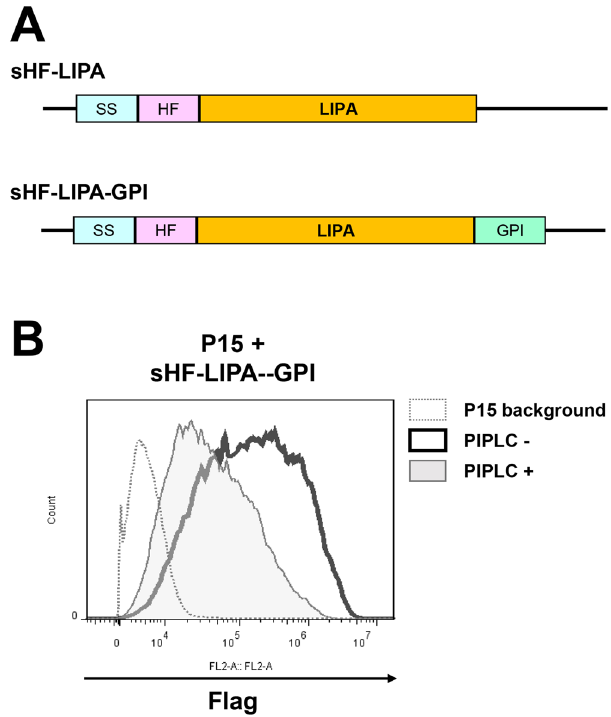
sequence (SS) and GPI attachment signal of human CD59 were used. ( B ) Flow cytometric analysis of sHF-LIPA- GPI on the cell surface of P15 cells. The cells were stained with an anti-Flag antibody and a PE-conjugated goat anti-mouse IgG. After PI-PLC treatment, surface expression of sHF-LIPA-GPI was found to